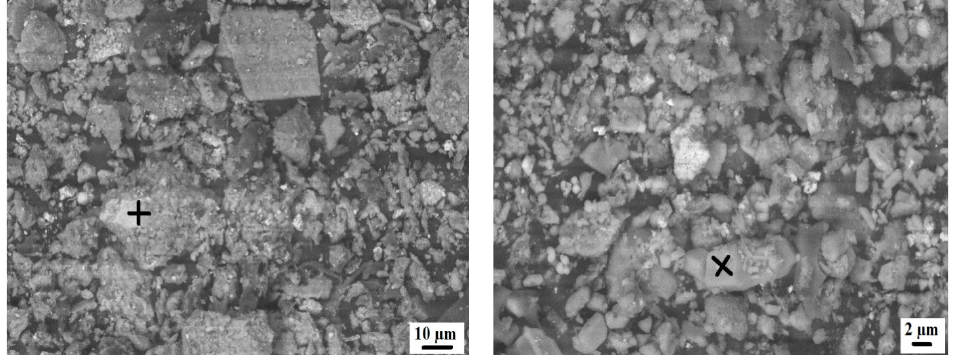
Figure 3. Microstructure of untreated coal ash.